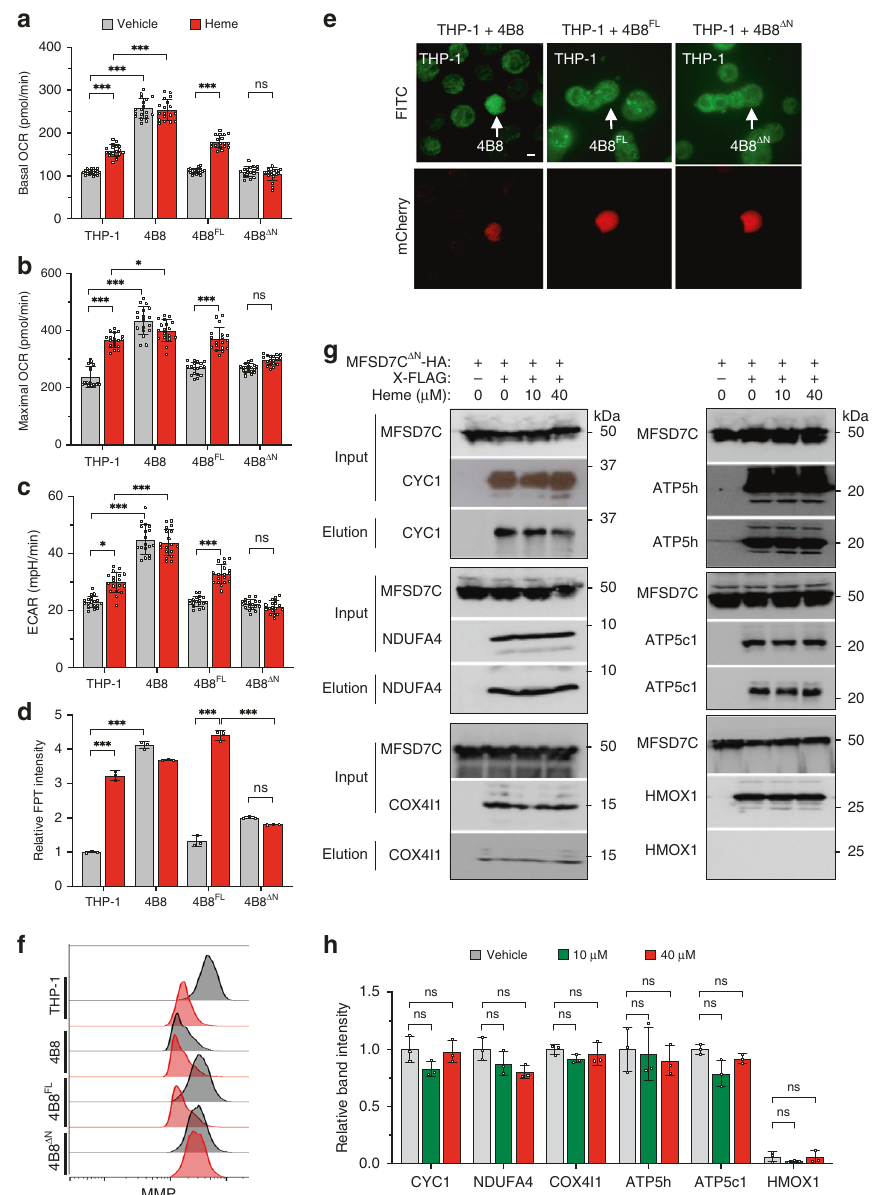
Fig. 4 NTD of MFSD7C mediates heme effect on mitochondrial respiration. a – c Comparison of basal OCR ( a ), maximal OCR ( b ), and ECAR ( c ) of THP-1, 4B8, and 4B8 FL , and 4B8 Δ N cells treated with vehicle or heme for 1 h ( n = 18 separate experiments). d Comparison of FPT intensity of THP-1, 4B8, 4B8 FL , and 4B8 Δ N cells. Cells were incubated with FPT for 6 h, washed and reseeded in poly-lysine coated glass bottom dishes. After cells attached to the glass, medium containing 40 μ M heme was added. Cells in the same fi eld were imaged immediately and again 1 h later. Relative FPT fl uorescent intensities, normalized to THP-1, from three experiments are shown. Representative images are shown in Supplementary Fig. 9e. ( n = 3 independent experiments). e Restoration of thermogenesis in 7CKO cells by expression of MFSD7C FL and MFSD7C Δ N . THP-1 cells were co-cultured with 4B8, 4B8 FL , or 4B8 Δ N in FPT solution for 6 h, washed and reseeded in poly-lysine coated glass bottom dishes. Cells were imaged by confocal laser-scanning microscopy. Green channel shows the FPT intensity and the red channel (mCherry) distinguishes knockout cells from the parental THP-1 cells. Representative images from three experiments are shown. Scale bar: 10 µ m. f Heme treatment reduces MMP in 4B8 cells complemented with MFSD7C FL but not MFSD7C Δ N . THP-1, 4B8, 4B8 FL , and 4B8 Δ N cells were treated with vehicle or heme for 1 h and MMP was measured by using JC-10 Mitochondrial Membrane Potential Assay Kit followed by fl ow cytometry. Representative mitochondrial staining pro fi les from three experiments are shown. g and h Heme does not disrupt MFSD7C Δ N interactions with ETC components. Co-IP was performed as in Fig. 2k, except HA-tagged MFSD7C Δ N was used. Shown are representative Western blotting data ( g ) and quanti fi cation of band intensities from n = 3 independent experiments ( h ). p values were calculated using two-way ANOVA (* p < 0.05, ** p < 0.01, *** p < 0.005). Data are presented as mean value ± standard disease is associated with rare variants of TREM2 32 . TREM2- Our fi ndings shed light on how dysfunctional mutations in Mfsd7c may cause Fowler syndrome 14 . Accumulating evidence de fi cient microglia exhibit impaired mTOR activation and pha- suggests that defects in energy metabolism play a critical role gocytosis, which can be corrected with provision of an ATP in neurodegeneration. For example, the late-onset Alzheimer ’ s precursor cyclocreatine 33 . Similarly, DNAJC30 interacts with